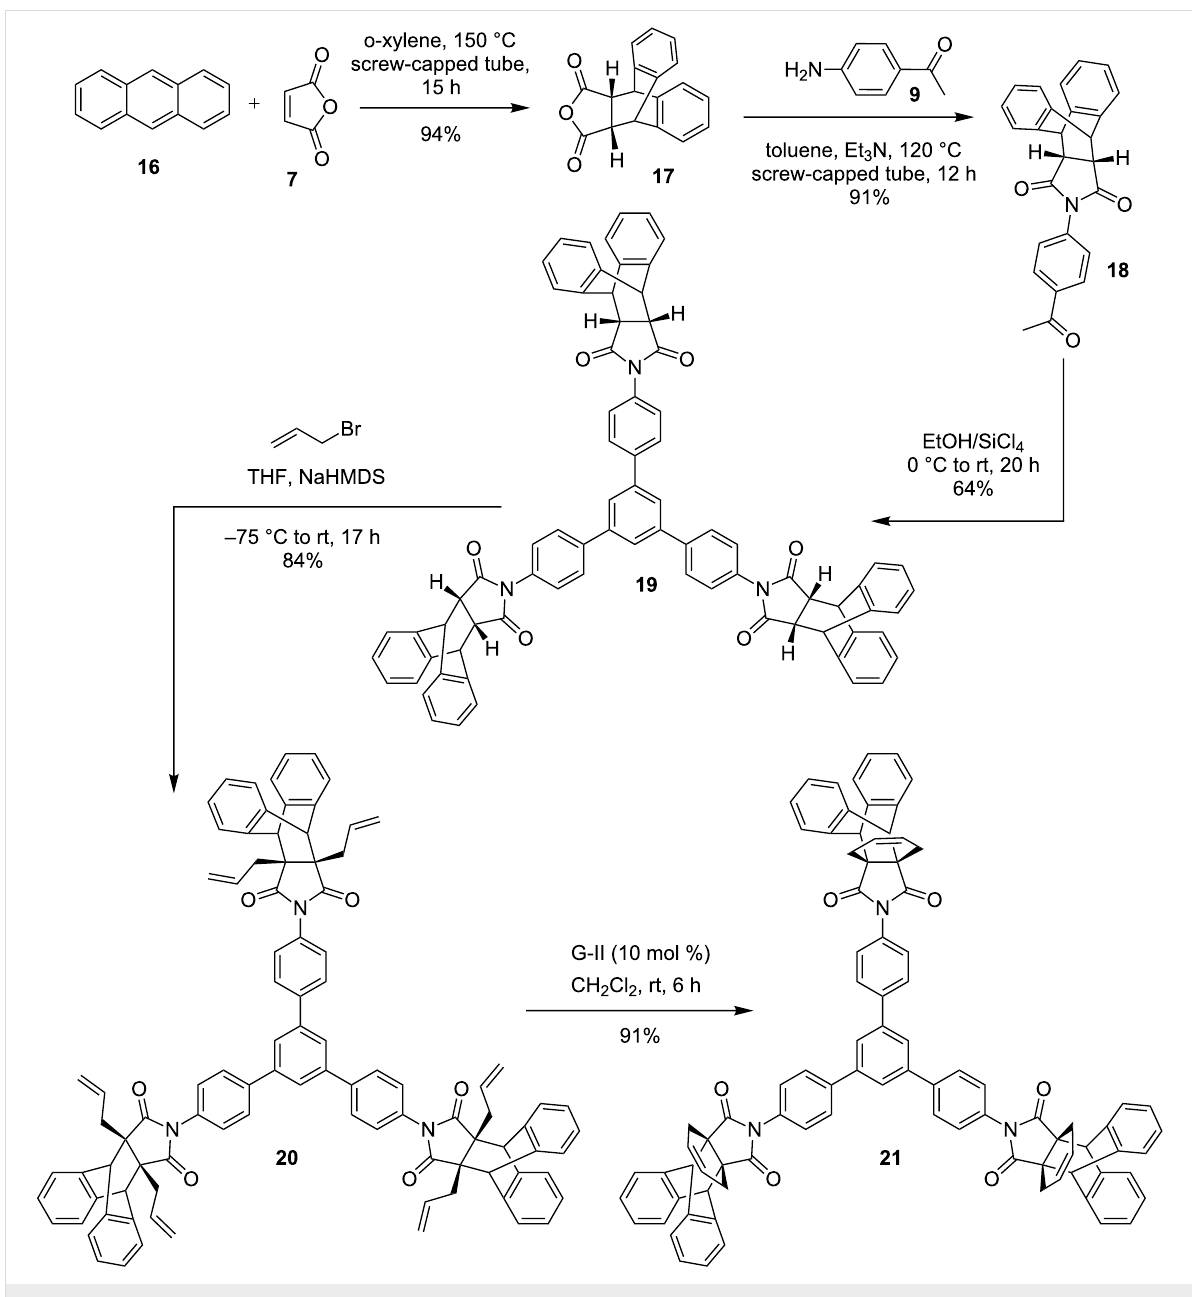
Scheme 3: Synthesis of C 3 -symmetric molecule 21 bearing propellane moieties via trimerization and RCM.